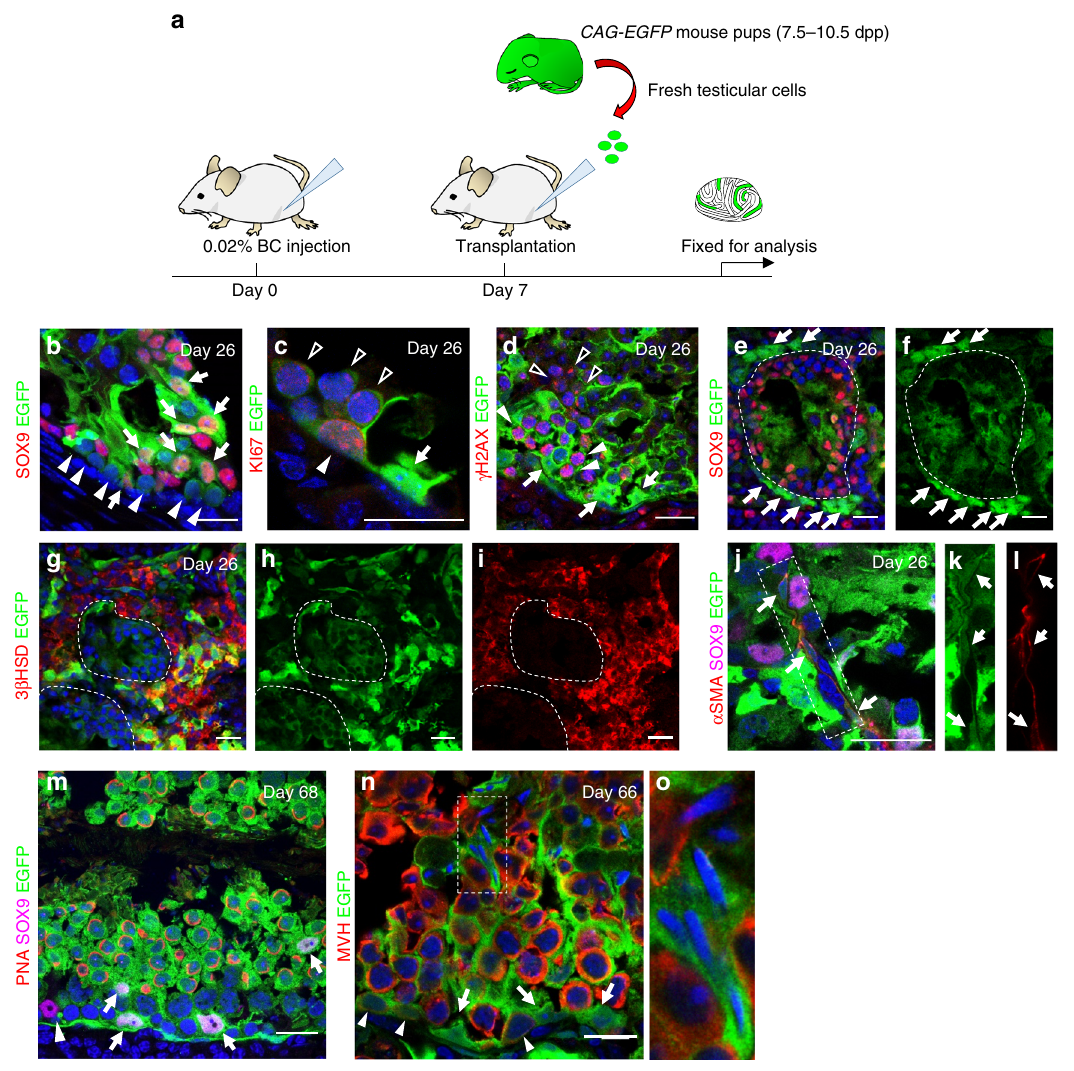
Fig. 5 Fresh donor testicular cells injected 7 days post-BC treatment reconstitute spermatogonial niche. a Schematic representation of experimental procedures for testicular cell transplantation 7 days after BC treatment. b – g Host testis 19 days after testicular cell transplantation from 9 dpp CAG-EGFP pups. CAG-EGFP (green) labels all transplanted cells. b Donor Sertoli cells (arrow, green) with nuclear SOX9 (red) and donor spermatogonia (arrowhead, round cells with large nuclei surrounded by green halo) colonize within cords. c Spermatocytes generated from donor spermatogonia (open arrowheads). Donor Sertoli cell (arrow) and donor spermatogonia (white arrowhead) positive for active cell cycle marker, KI67 (red). d Donor Sertoli cell (arrow) fosters donor spermatocytes: leptotene spermatocytes (white arrowhead), pachytene spermatocytes (open arrowhead) label with γ H2AX (red). e , f In addition to donor cells inside tubules, some of which express SOX9 (red), many SOX9-negative cells colonized outside of tubules. g – i Donor Leydig cells expressing 3 β HSD (red) colonized the interstitium, and j – l donor PMCs (arrow; α SMA (red)) surrounded testis cords (region within dotted rectangle is magni fi ed to the right in the green channel; green myoid cell is outlined in red). SOX9 (magenta). m Recipient testis 61 days after 7 dpp CAG-EGFP testicular cell transplantation. SOX9 (magenta) labels both donor Sertoli cells (arrows) and a remaining host Sertoli cell (arrowhead). PNA (red) co-labels many donor spermatogonia (green). n Host testis 59 days after testicular cell transplantation from 10 dpp CAG-EGFP donors. Donor Sertoli cells (arrow, green) surround elongating sperm labeled with MVH (red). Donor-derived spermatogonia persist on the basement membrane (arrowhead). o Higher magni fi cation view of the region surrounded by broken lines shows elongating sperm. Donor spermatogenesis with multiple cell type colonization was observed in 9 of 13 biologically independent testes examined over four independent experiments. Scale bar: 25 µ